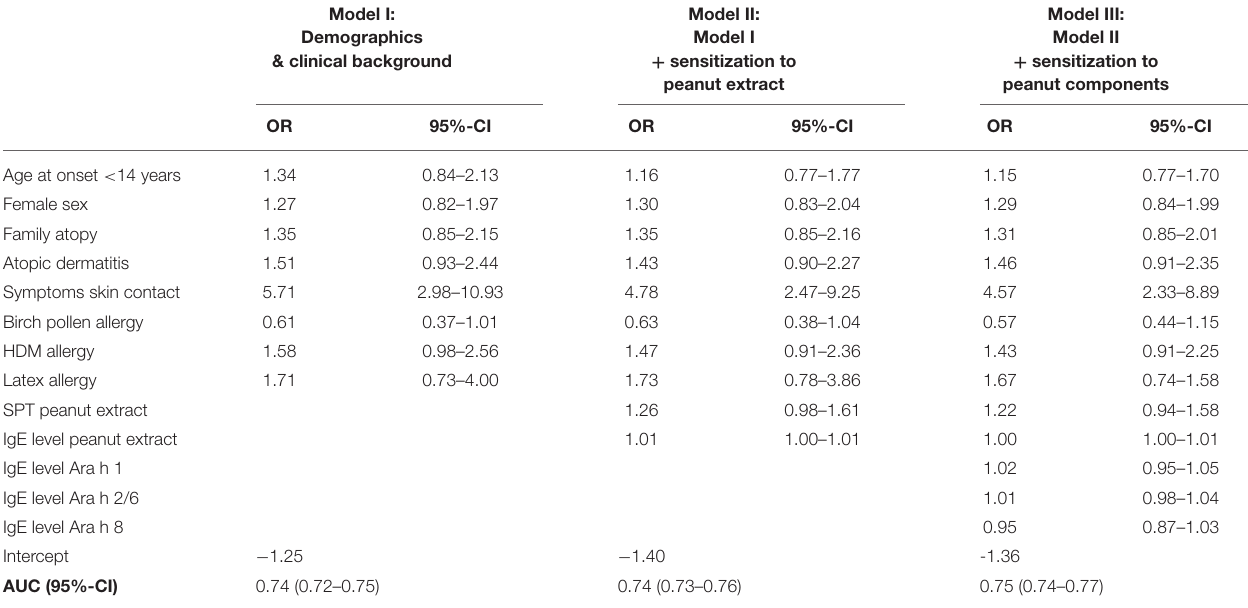
TABLE 2 | Prediction models for severity of probable PA.